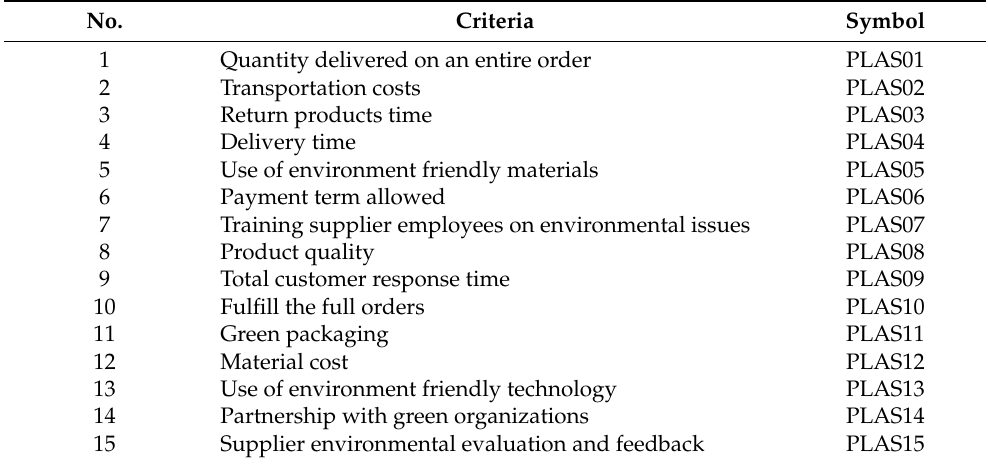
Table 1. Criteria list.